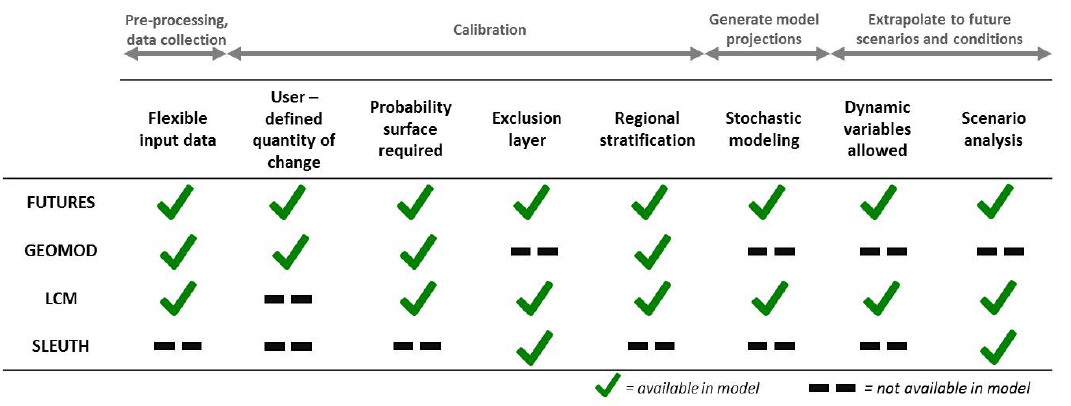
Table 1. General work flow followed by each LULC model with specific characteristics highlighted to show differences in each model’s